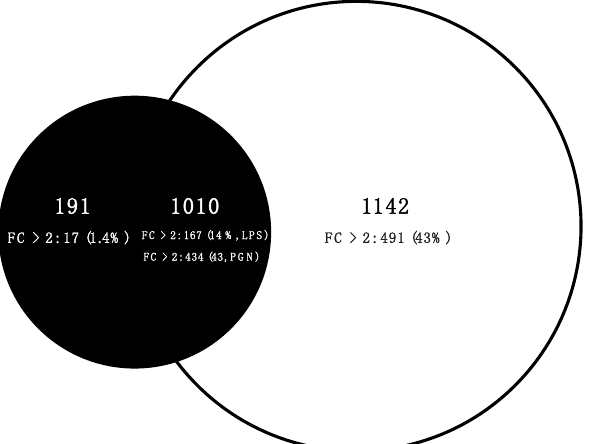
Figure 4. Venn diagram summarizing the quantitative variation of gene expression. The numbers inside the Venn diagrams indicate the number of mRNAs by treatment; number and percentage of mRNA probes with a fold change over 2 ( FC > 2) by treatment. The semicircular portion of the Venn diagram represents the overlaps between differentially expressed transcripts (FDR 5%) of both treatments PGN and LPS, which represent 53% and 84% of their transcriptomic response, respectively. White circle PGN, Black circle LPS.